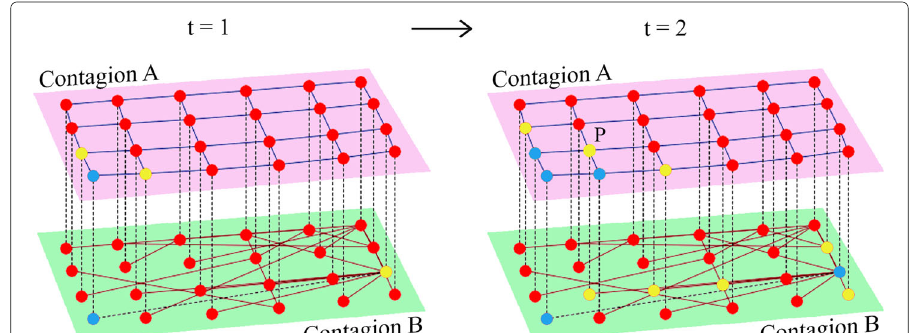
Fig. 1 Model schematic of co-contagion diffusion. All nodes have a one-to-one correspondence to themselves between layers. At time step 1 (left), assume the blue node is infected with both Contagions A and B . Contagion A only diffuses on the top lattice layer, and Contagion B diffuses on the bottom power-law layer. Yellow nodes denote nodes that are susceptible to infection, whose adaption probability depends on neighbors who are infected (blue over total neighbors). Assuming all susceptible nodes adopt respective contagions this round, the right diagram shows adoption of A and B by time step 2. Contagion B has now infected a hub with five neighbors, shown in yellow. Individual P will decide whether to adapt A and B , based on the denisties of both A and B from both layers. When dormancy is considered, blue nodes are excluded from the numerator as illustrated in Eq. 2